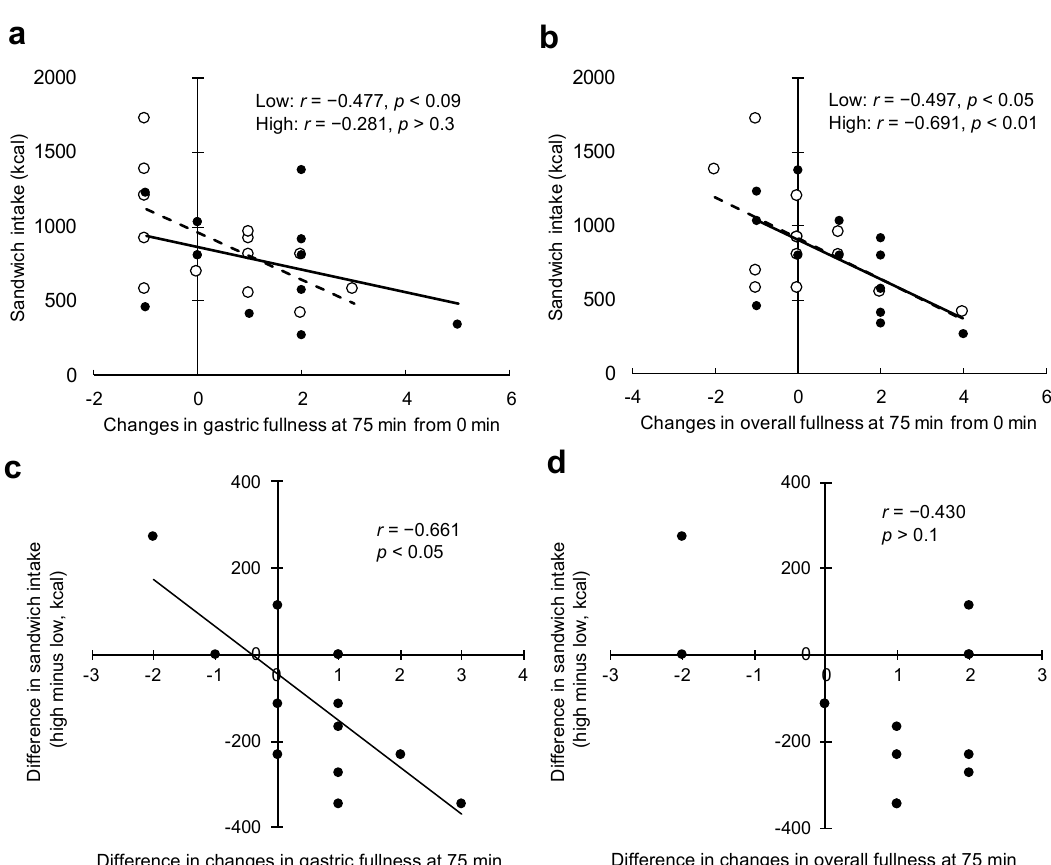
Figure 3. Association between subjective appetite and energy intake from sandwiches. ( a ) Scatter plots between changes in gastric fullness at 75 min (from 0 min) and energy intake from sandwiches. ( b ) Scatter plots between changes in overall fullness at 75 min (from 0 min) and energy intake from sandwiches. ( c ) Scatter plots between the di ff erence in changes in gastric fullness at 75 min (from 0 min) and the di ff erence in energy intake from sandwiches. ( d ) Scatter plots between the di ff erence in changes in overall fullness at 75 min (from 0 min) and the di ff erence in energy intake from sandwiches. Broken lines on ( a ) and ( b ) show the low energy load condition; dashed lines on ( a ) and ( b ) show the high energy load condition.